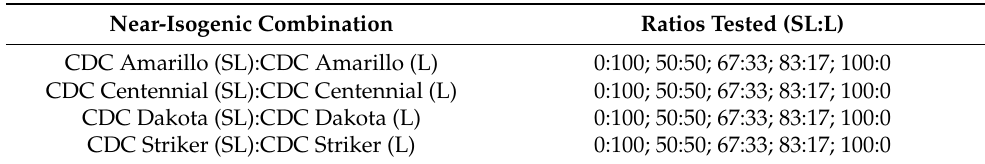
Table 2. Near-isogenic semi-leafless and leafed lines grown in five mixing ratios at five locations in 2017, 2018, and 2019. Near-Isogenic Combination Ratios Tested (SL:L) CDC Amarillo (SL):CDC Amarillo